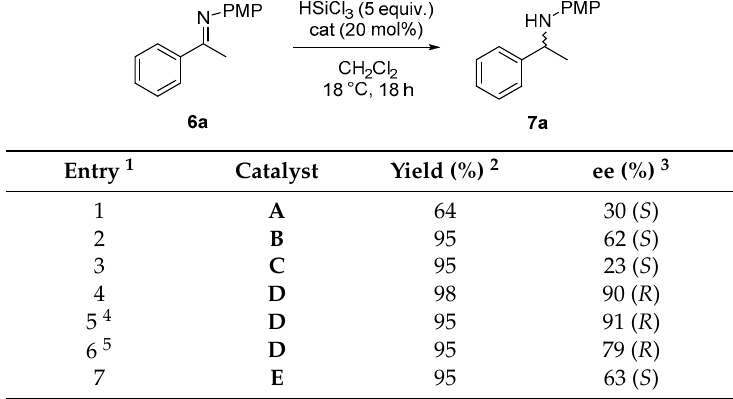
Molecules 2016 , 21 , 1182